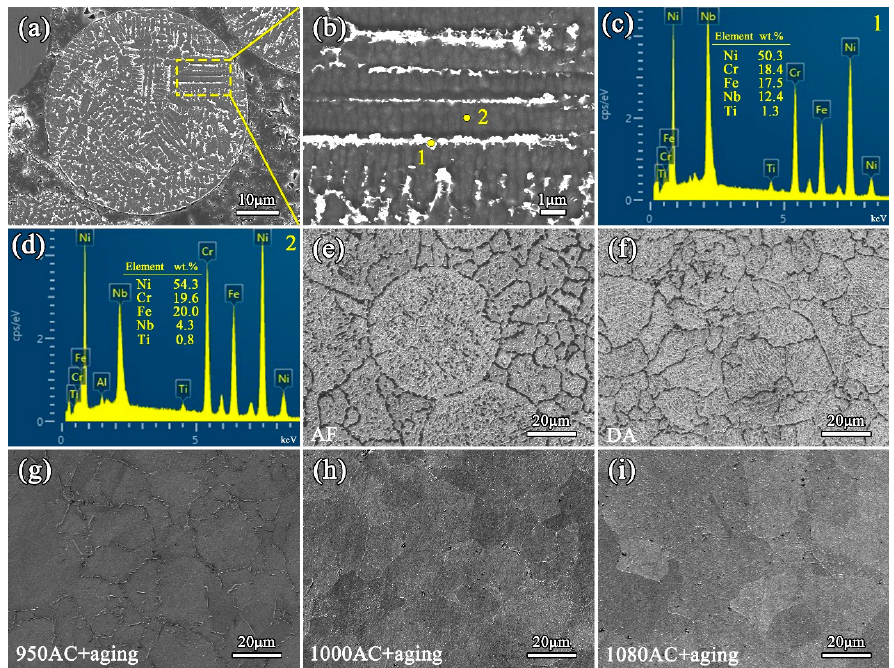
Figure 2. ( a ) Cross-sectional morphology of the IN718 powder . ( b ) The enlarged view of the powder microstructure in the region marked in ( a ). ( c , d ) Energy disperse spectroscopy (EDS) spectra and elemental contents of location 1 and 2 (marked in ( b )), respectively. ( e – i ) Microstructures of the as-fabricated, direct aging (DA), 950AC+aging, 1000AC+aging, and 1080AC+aging samples.